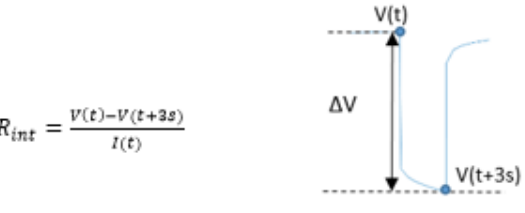
Figure 4. Internal Resistance evaluation during a 3 s resting